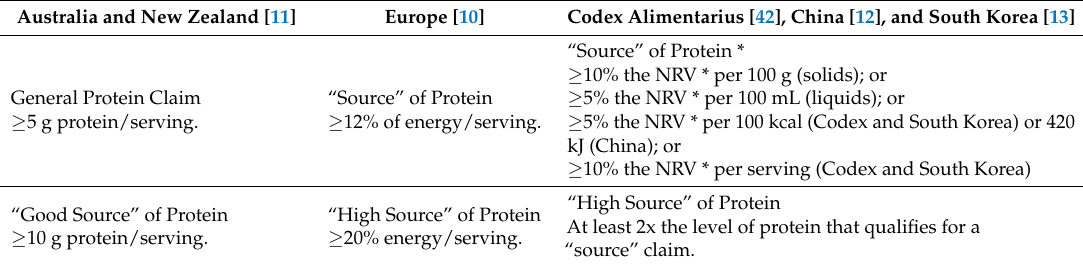
Table 2. Summary of alternative regulatory frameworks and international foods standards (Codex Alimentarius) for protein content